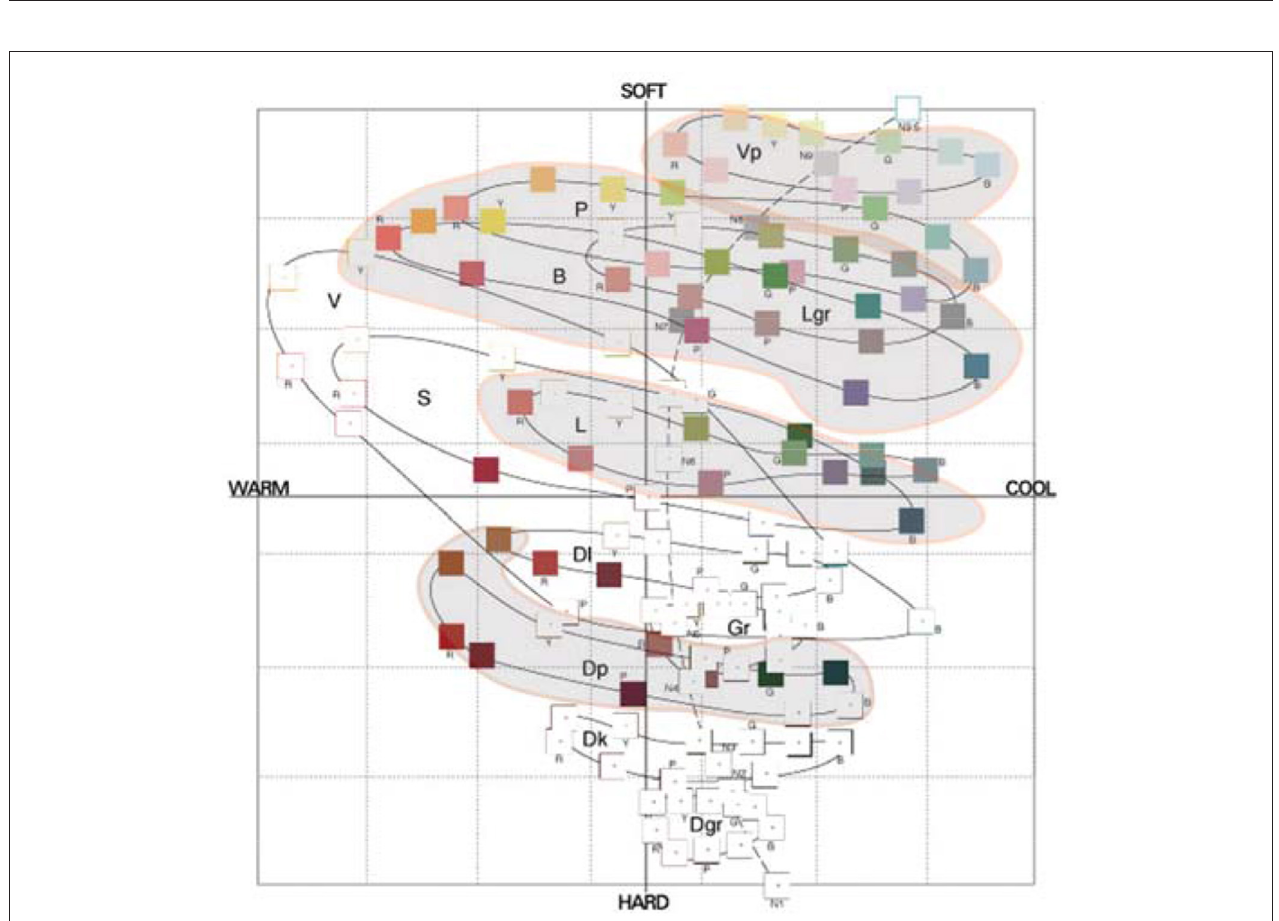
FIGURE 4 | Color distribution of cosmetic packaging in image